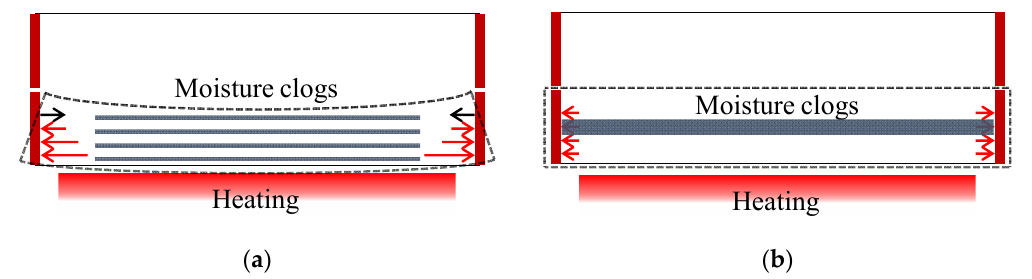
Figure 13. Schematic of vapor pressure and restrained stress of 100-MPa concrete according to heating rate. ( a ) Fast heating (ISO-824). ( b ) Slow heating (1 °C/min).